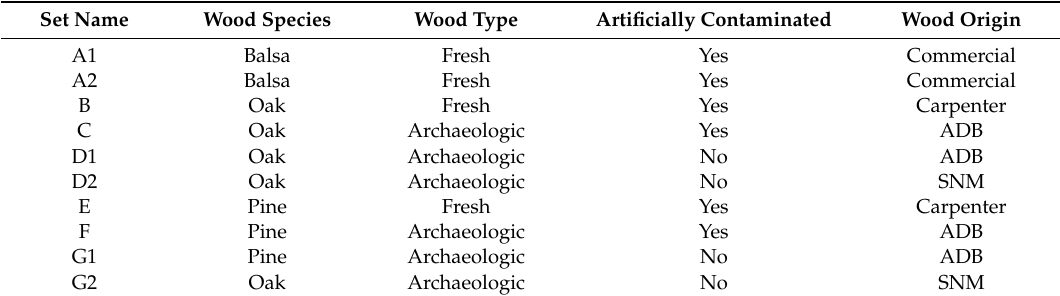
Table1. Sampleinformationanddistributionbasedonwoodspecies, woodtype, artificialcontamination and provenance (ADB: Archaeological Service of Bern Canton and SNM: Swiss National